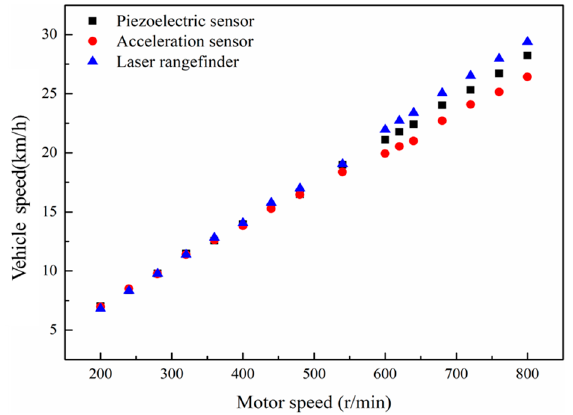
Figure 4. Relation between motor speed and device